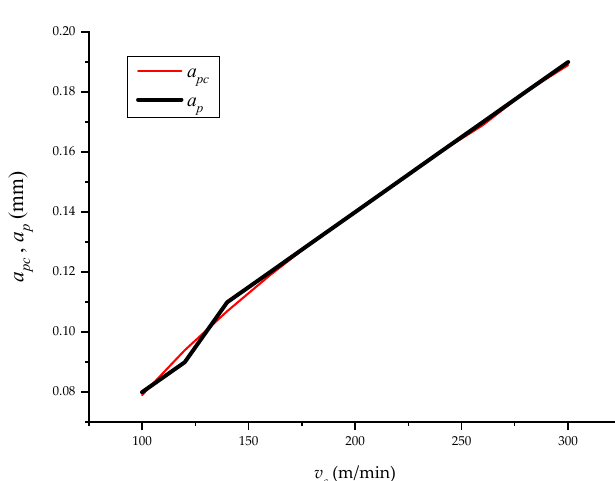
Figure 9. Comparison of ( a p , a pc ) = f ( v c ) according to values in columns 3 and 12 in Table 1; a p chosen, a pc calculated for control according to Equation (23), below .